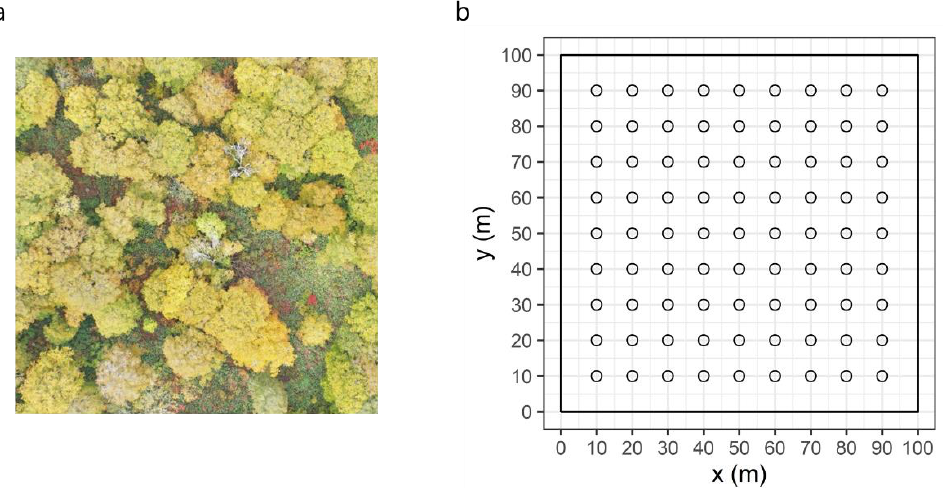
Figure 2. ( a ) Aerial photograph of the study plot taken in October 2019. ( b ) Schematic of LAI measurement points. x and y indicate coordinates in the study plot; ○ LAI measurement points.